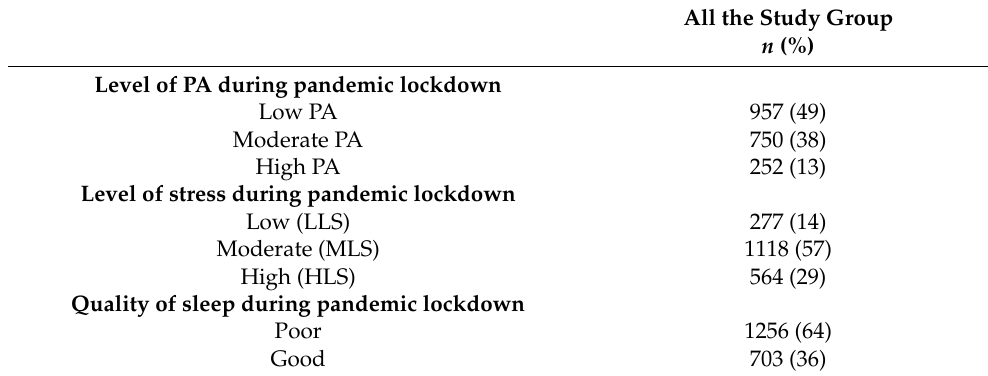
Table 2. The characteristics of the study participants regarding the volume of PA, level of stress and quality of sleep ( n =